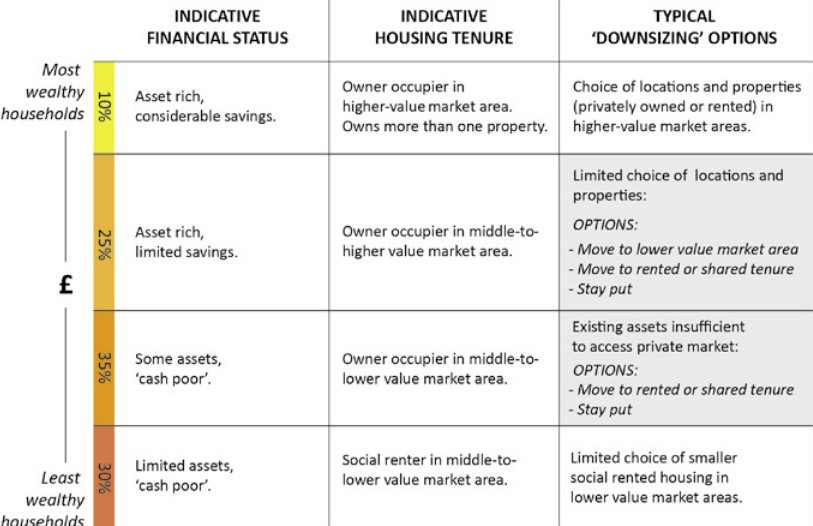
Figure 2. The impact of tenure and asset wealth on downsizing options – building on modelling by Ball and Nanda. Image: